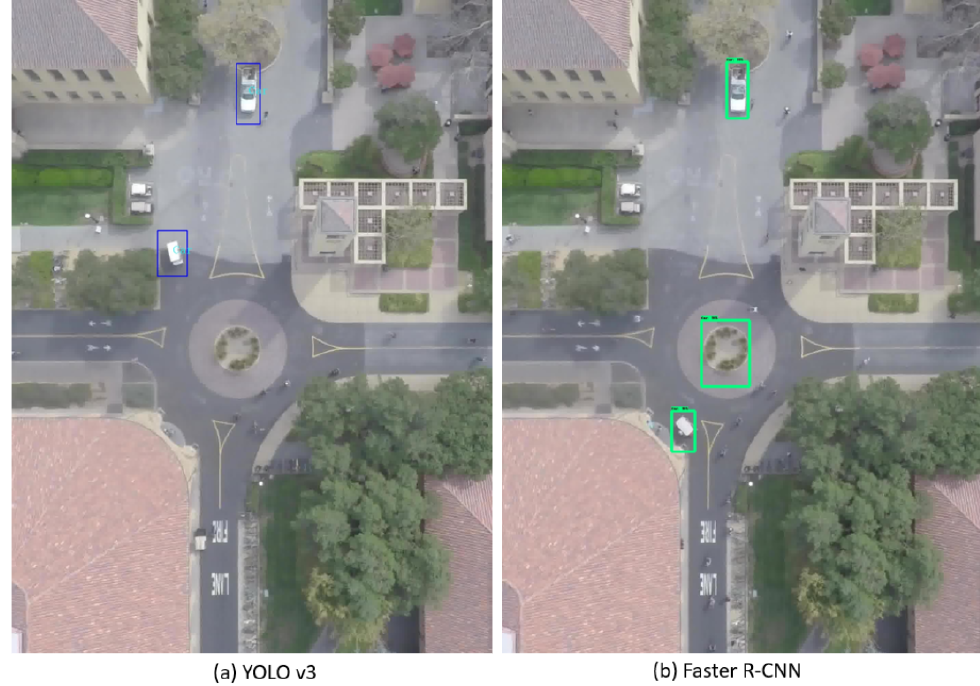
Figure 10. Example of ( a ) YOLOv3 and ( b ) Faster R-CNN’s output on a sample image of the Stanford